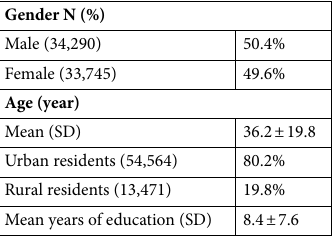
Table 1. Demographics of the participants.